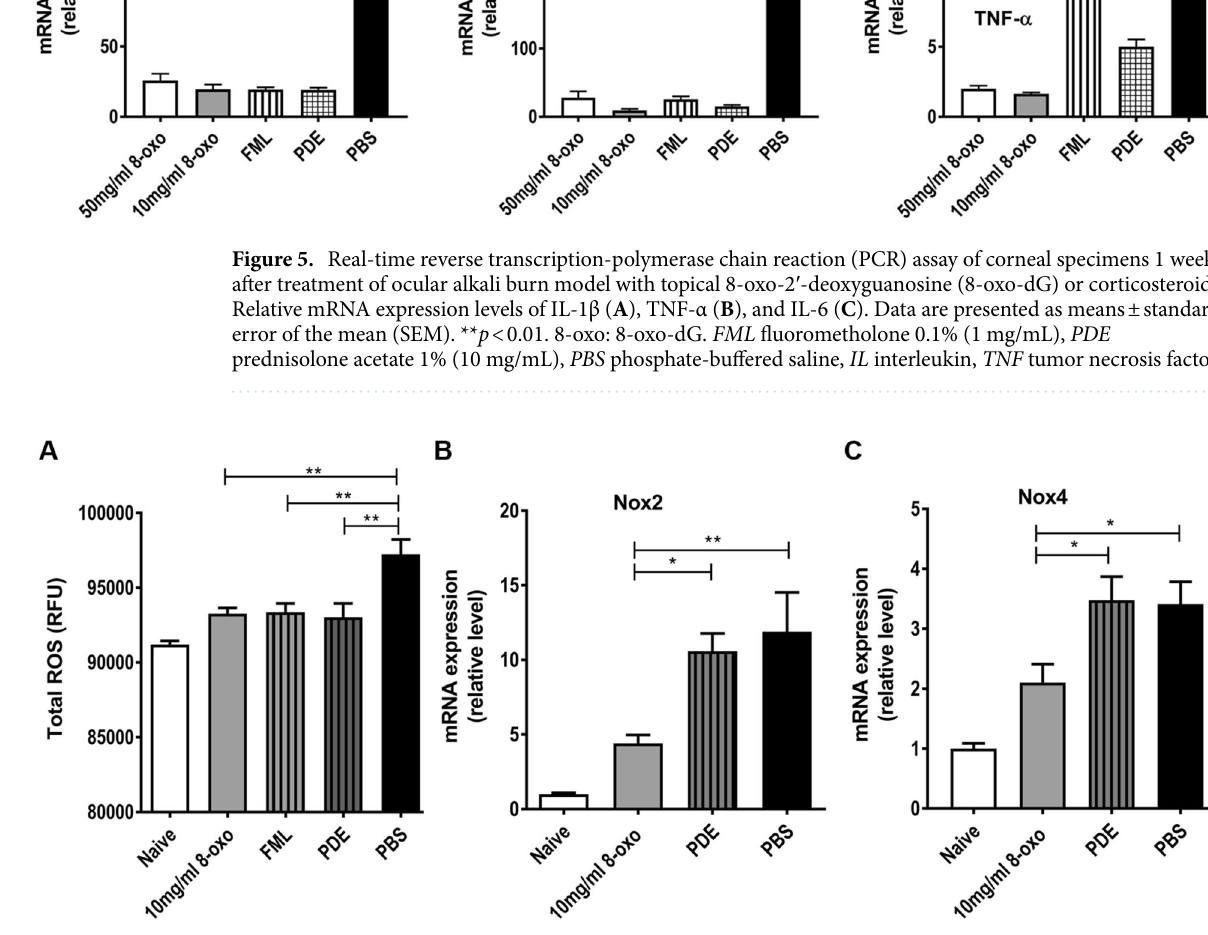
Figure 6. Reactive oxygen species (ROS) and reactive nitrogen species (RNS) assays of corneal specimens 1 week after treatment with topical 8-oxo-dGor corticosteroid in ocular alkali burn models. ( A ) Real-time reverse transcription PCR assays of corneal specimens after treatment of ethanol-induced chemical injury model with 8-oxo-2 ′ -deoxyguanosine (8-oxo-dG). Relative mRNA expression levels of ( B ) Nox2 and ( C ) Nox4. Data are means ± standard error of the mean (SEM). * p < 0.05 and ** p < 0.01. RFU: relative fluorescence units. 8-oxo: 8-oxo-dG. FML fluorometholone 0.1% (1 mg/mL), PDE prednisolone acetate 1% (10 mg/mL), PBS phosphate buffered saline, Nox2 nicotinamide adenine dinucleotide phosphate (NADPH) type 2 oxidase, Nox4 nicotinamide adenine dinucleotide phosphate (NADPH) type 4